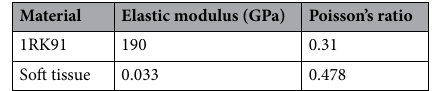
Table 1. Mechanical properties used for the FEA model 11–13 .